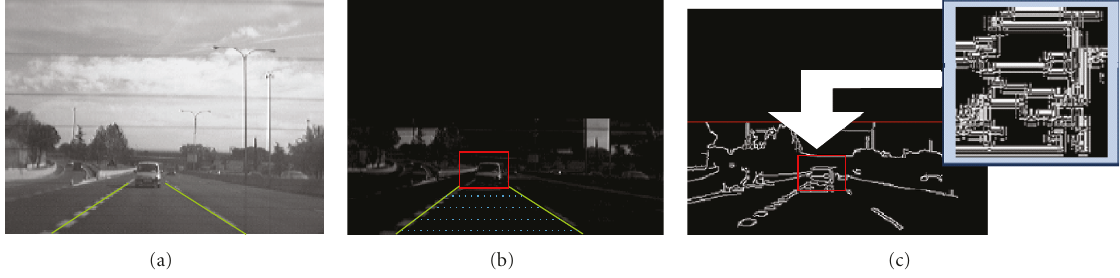
Figure 8: From left to right: original image; contact point detection on white top-hat image; candidate preselected with high entropy of Canny points.